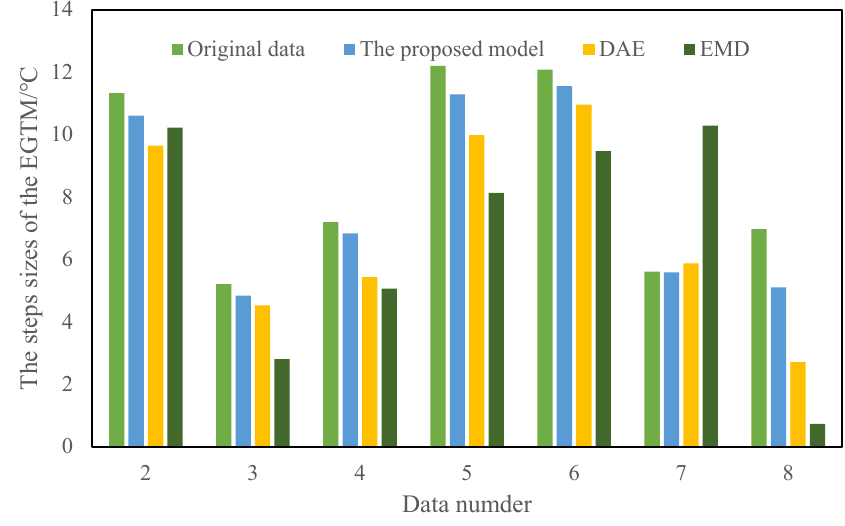
Figure 16. The step sizes from data of all models. Table 13. Step of each segment of data.